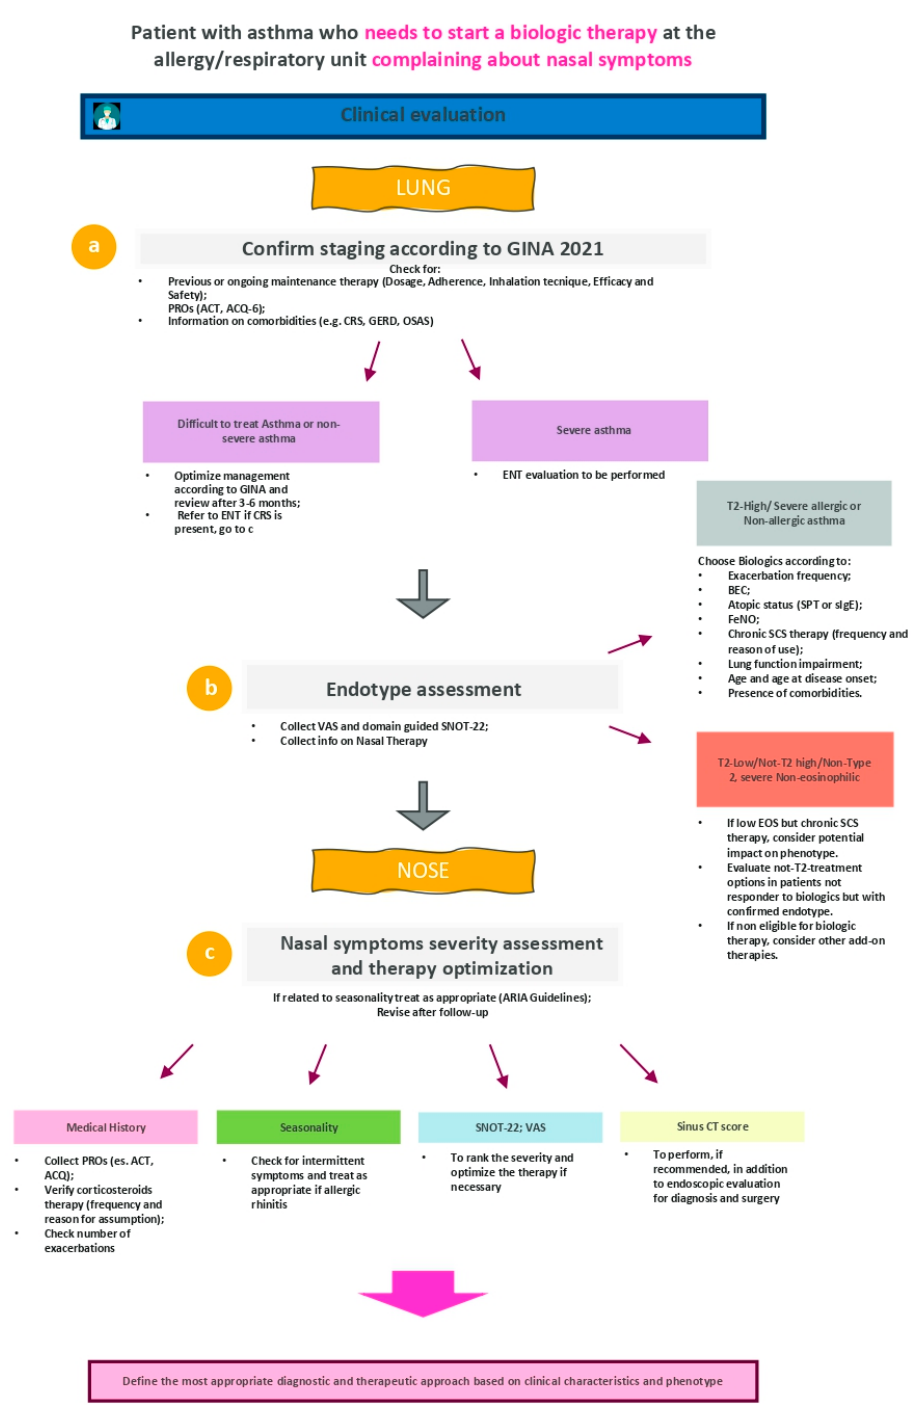
Figure 2. Detailed flow for the management of a patient with asthma who needs to start a biologic therapy at the allergy/pulmonary unit complaining about nasal symptoms. GINA = Global Initiative for Asthma; ENT = ear, nose and throat specialist; EOS = eosinophil count; BEC = blood eosinophil count; SPT = Skin prick test; sIgE = serum immunoglobulin E; FeNO = fractional exhaled nitric oxide; SCS = systemic corticosteroids; T2 = type-2; CRS = chronic rhinosinusitis; INCS = intra nasal corticosteroids; VAS = visual analogic scale (for nasal symptoms); SNOT-22 = sino-nasal outcome test on 22 items; PROs = patient-reported outcomes.